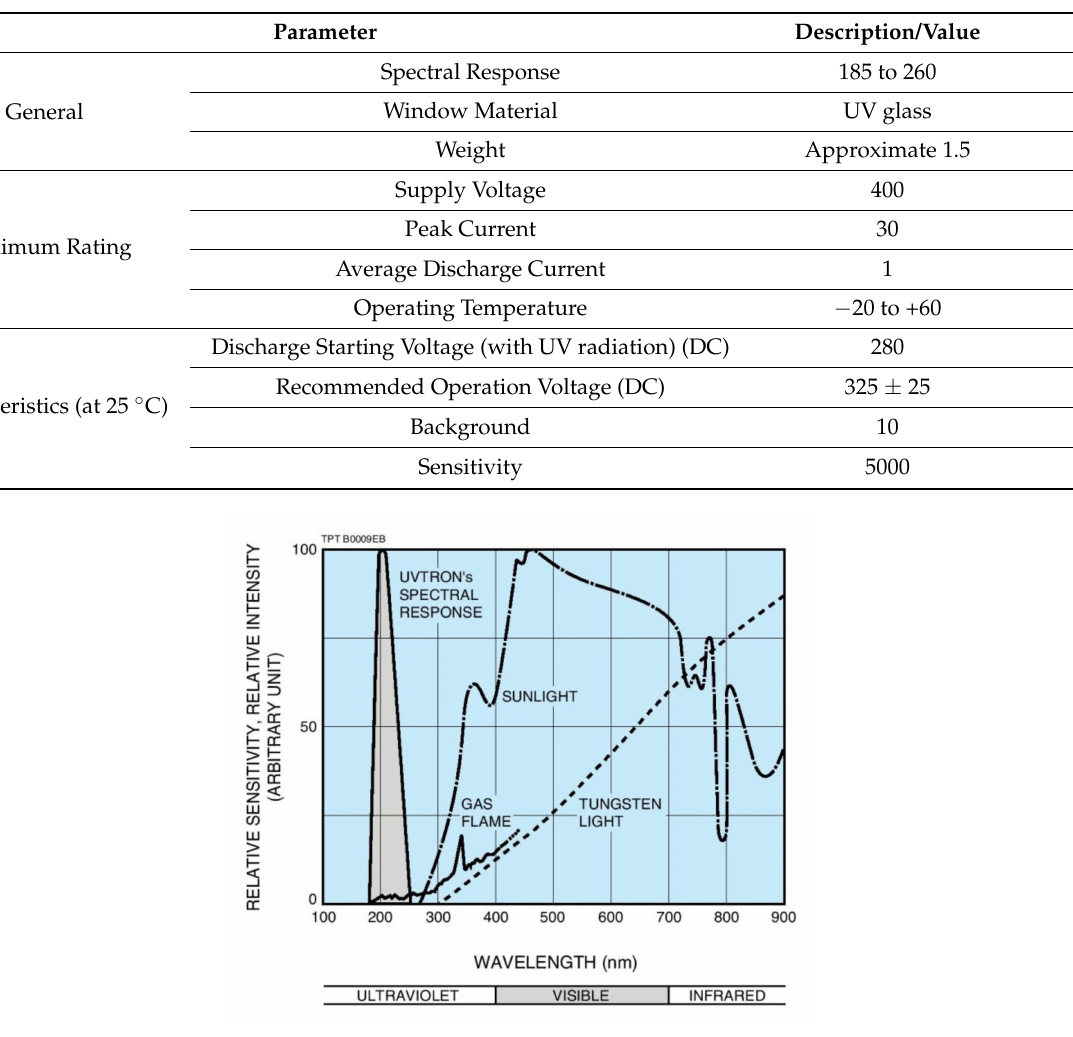
Table 2. UVTRON R2868 sensor specification.